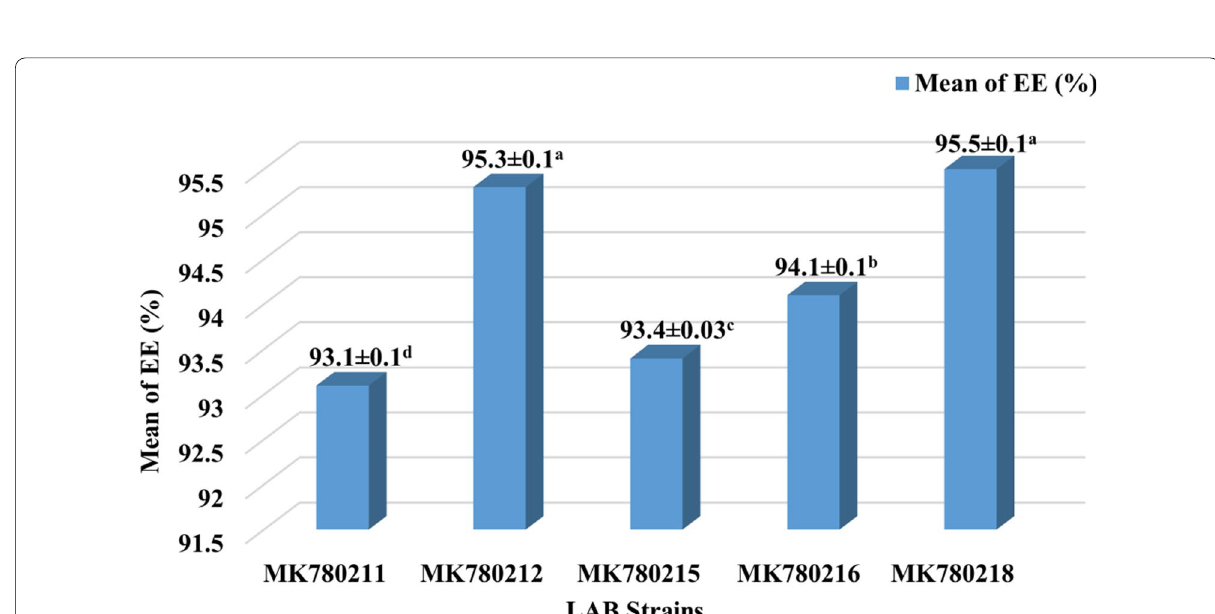
STD). Uppercase letters are results of Tukey test. a − d Means ± ≤